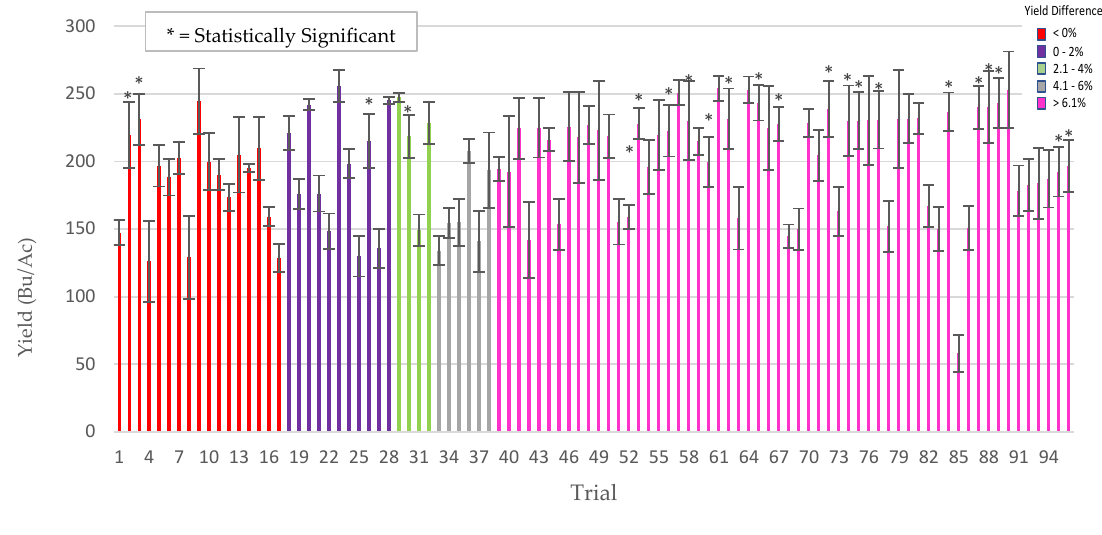
Figure 8. Corn response to low stress conditions. From 2013–2017, 96 trials were performed in 17 US states using 35 commercial varieties with standard PPP’s. Each bar is a separate trial comparing yields of treated (ThMS3a) vs untreated plants. Plots sizes varied from 10 ft × 50 ft to 5 acres with 4–8 replications/trial. Bars are color coded according to yield differences (Bu/Ac) indicated in the legend (upper right of graph). Bars with an asterisk symbol (*) indicate yield significance ( t test, p -value < 0.05). Cooperators: seed companies, farmers, CRO’s, universities, Ag distributors. Similar results were observed in winter wheat with an average yield increase of 5.3% and a win rate of 82% (tests with yield increases above 2%) (Figure 9). Under low stress, ThSM3a increased yields of alfalfa an average of 12.7% with a win rate of 85% (tests with yield increases above 5%) (Figure